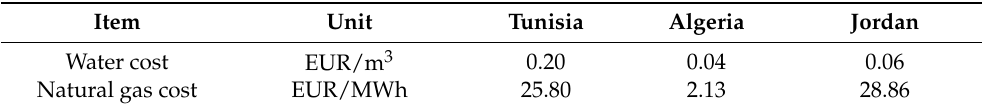
Table 2. Water and natural gas